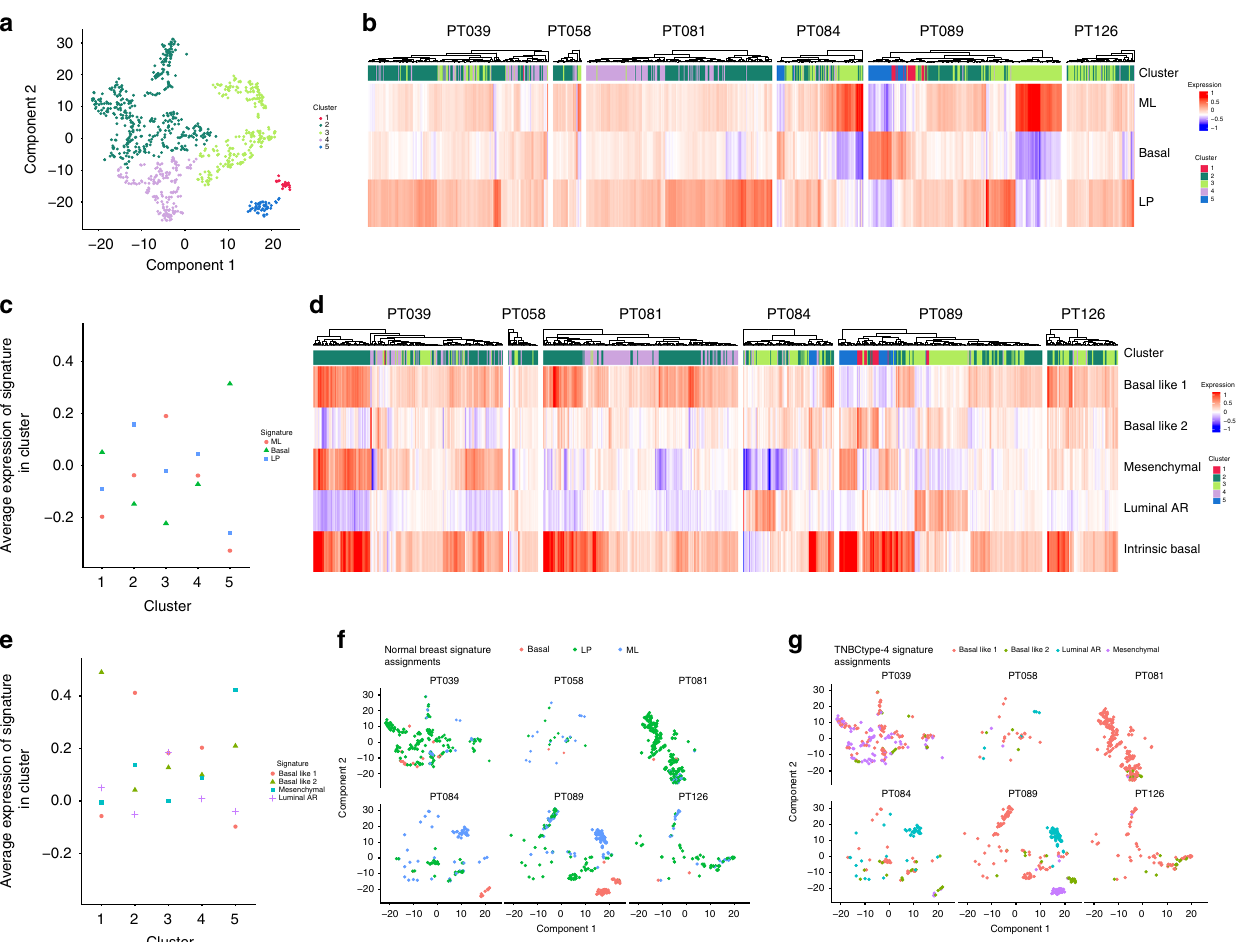
Fig. 3 Subpopulations of malignant epithelial cells share common expression pro fi les. a t-SNE plot of epithelial cells showing the fi ve identi fi ed clusters. Patient-speci fi c effects have been excluded through linear regression analysis. b Heatmap depicting the cluster assigned to each cell (top) and the corresponding expression of three normal breast epithelial subtypes signatures: ML (mature luminal), basal, and LP (luminal progenitor). c Average expression of each of the three normal breast epithelial subtype signatures in the epithelial clusters. Clusters 2 and 4 most strongly express the LP signature, while cluster 3 most highly expresses the ML signature. d Heatmap depicting the cluster assigned to each cell (top) and the corresponding expression of the four TNBCtype-4 subtype signatures and the Intrinsic Basal signature. e Average expression of each of the four TNBCtype-4 subtype signatures in the epithelial clusters. Clusters 2 and 4 most strongly express the proliferative Basal-Like 1 signature, while cluster 3 prominently expresses this signature and the luminal AR signature. f Assignment of each TNBC epithelial cell to a single normal breast epithelial subtype signature, depending on the difference between its average expression of the upregulated genes characterizing the signature, and the average expression of the downregulated genes. The plurality of cells in all tumors is LP-like, except for tumor 84, which is predominantly comprised of ML-like cells. g Assignments of each TNBC epithelial cell to a single TNBCtype-4 subtype signature depending on the difference between its average expression of the upregulated genes characterizing the signature, and the average expression of the downregulated genes. Multiple TNBCtype-4 subtypes are expressed among the